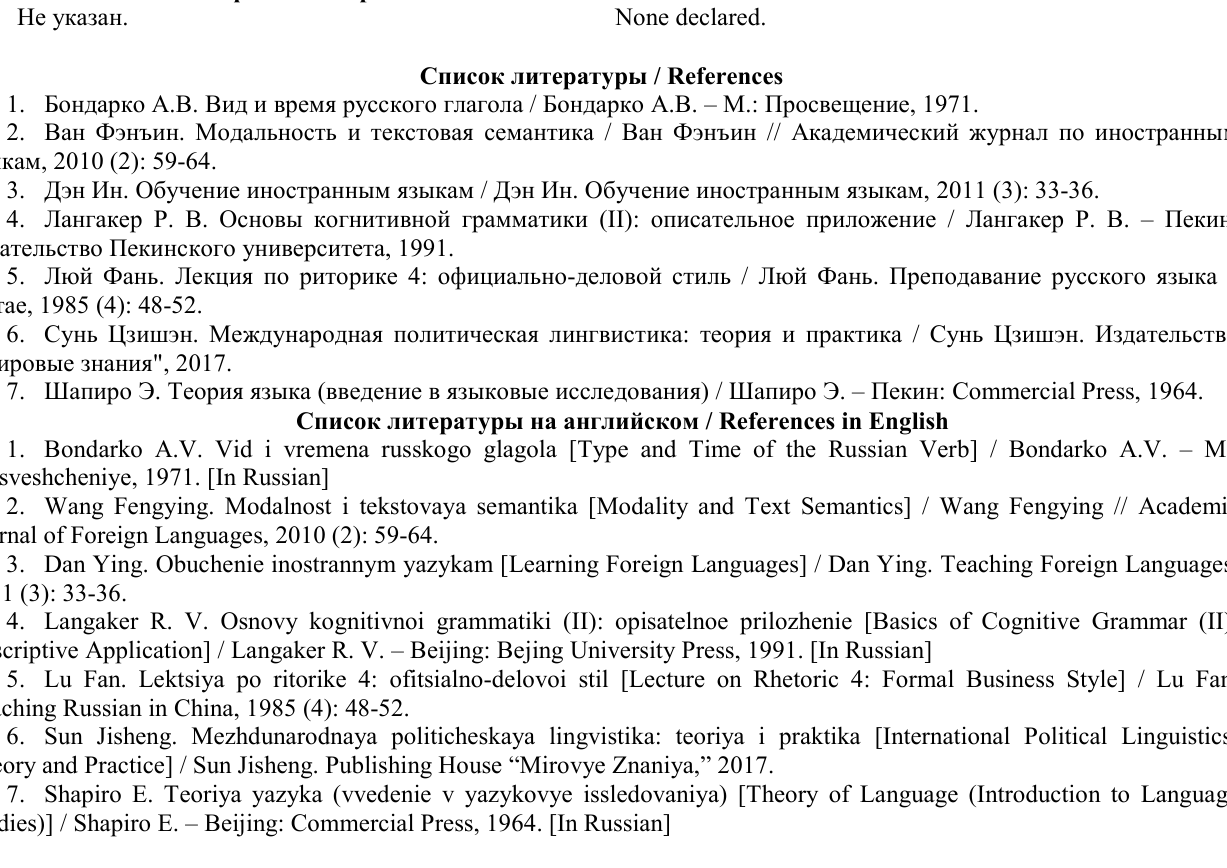
Государства - члены ШОС убеждены, что Организация может и должна внести заметный вклад в безопасное и стабильное развитие не только на ее пространстве, но и в мире в целом. (The SCO member states are convinced that the Organization can and must make a significant contribution to the safe and stable development not only on its territory, but also in the whole